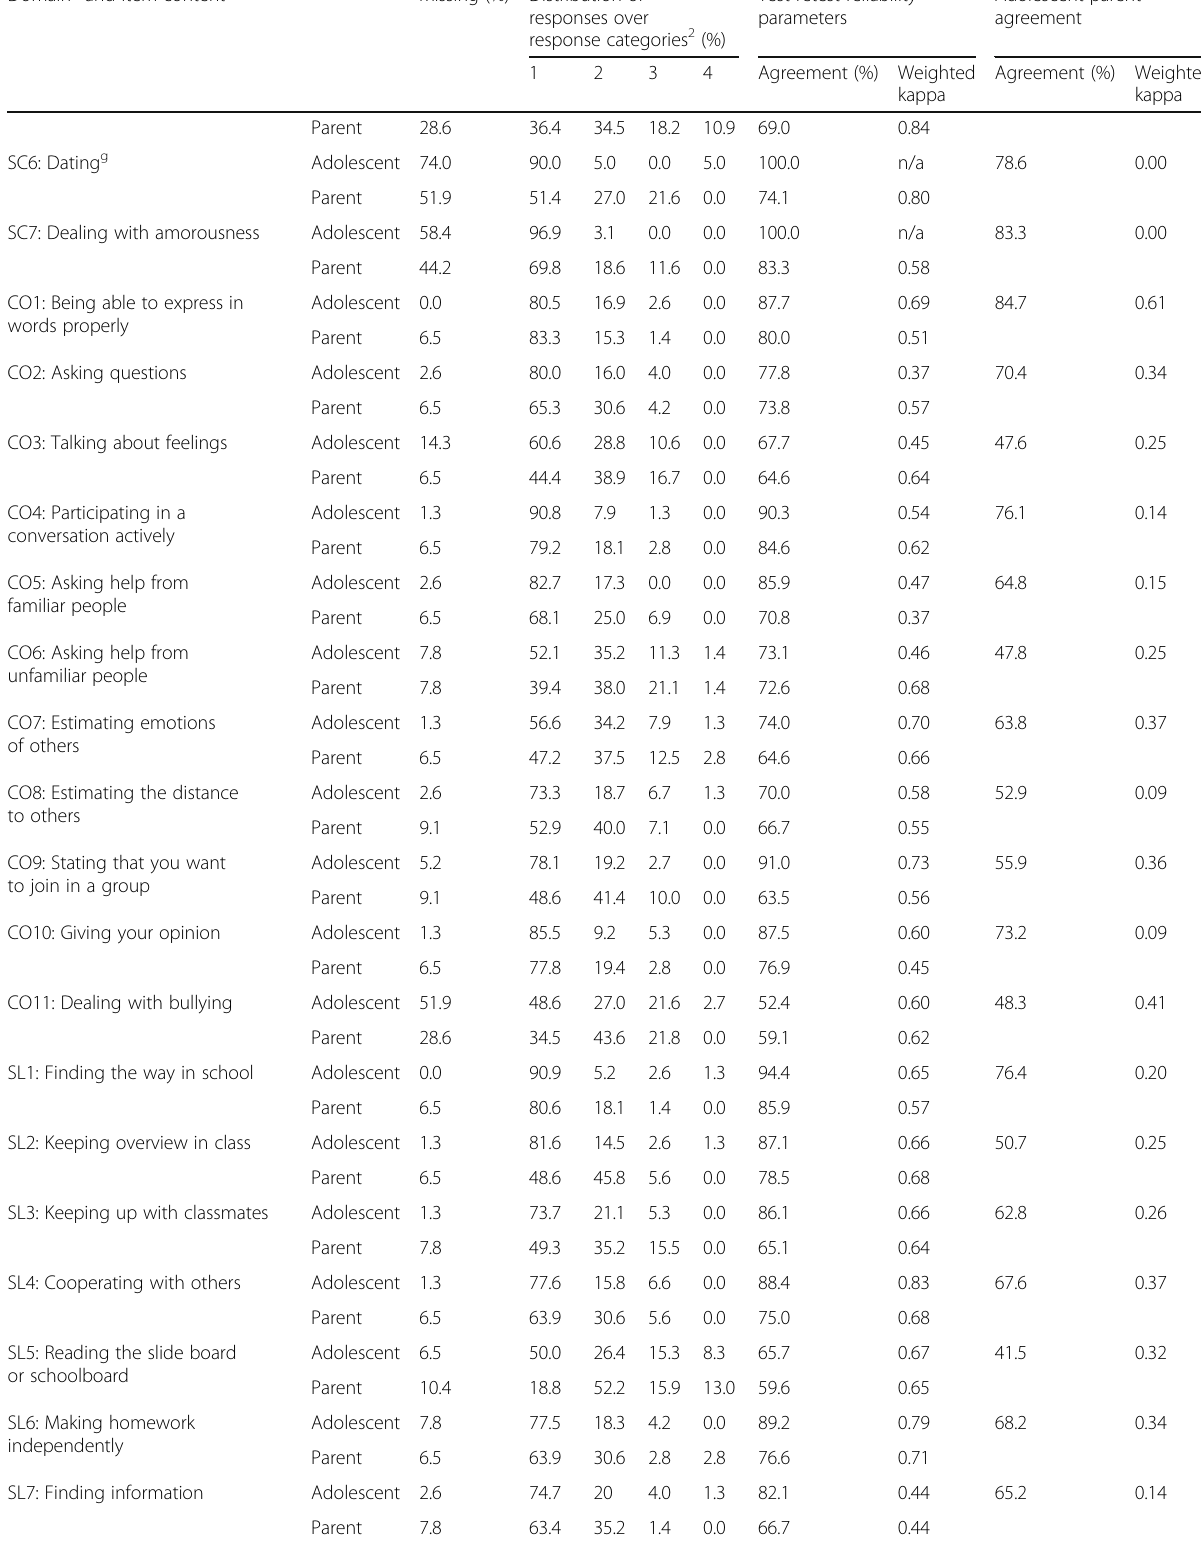
Table 2 Distribution of responses and parameters of test-retest reliability and adolescent-parent agreement (Continued) Domain 1 and item